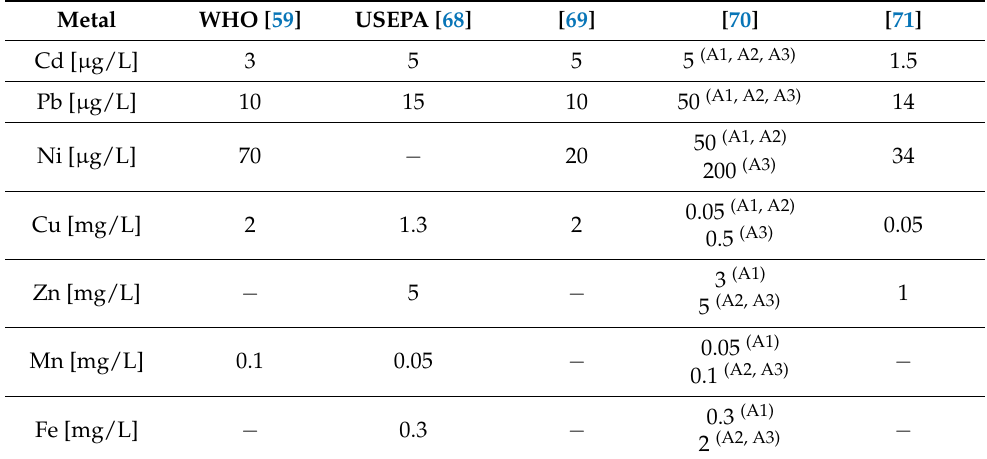
Table 3. Limits of metal concentrations according to the WHO, USEPA, and Polish